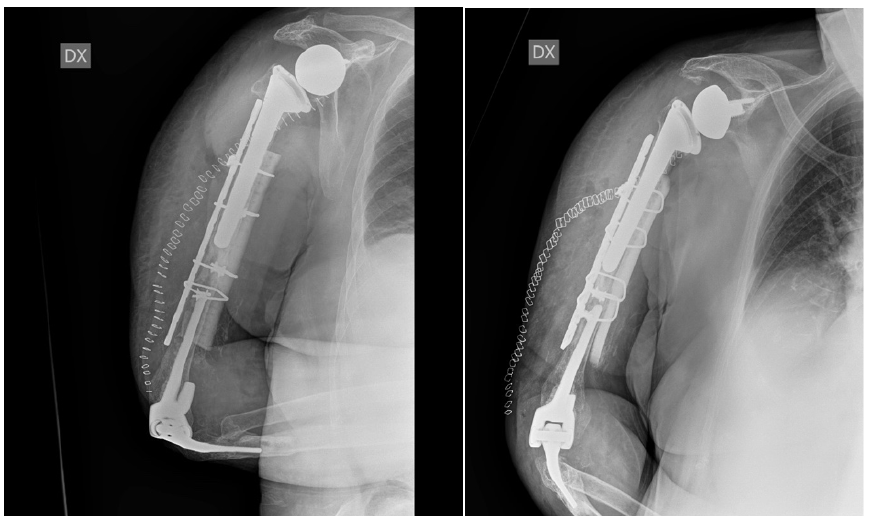
Figure 3. Postoperative X ‐ ray at 1 day. The X ‐ rays show good reduction and alignment of the fracture, good fixation and strut position, and stability of the previously implanted shoulder and elbow prostheses.